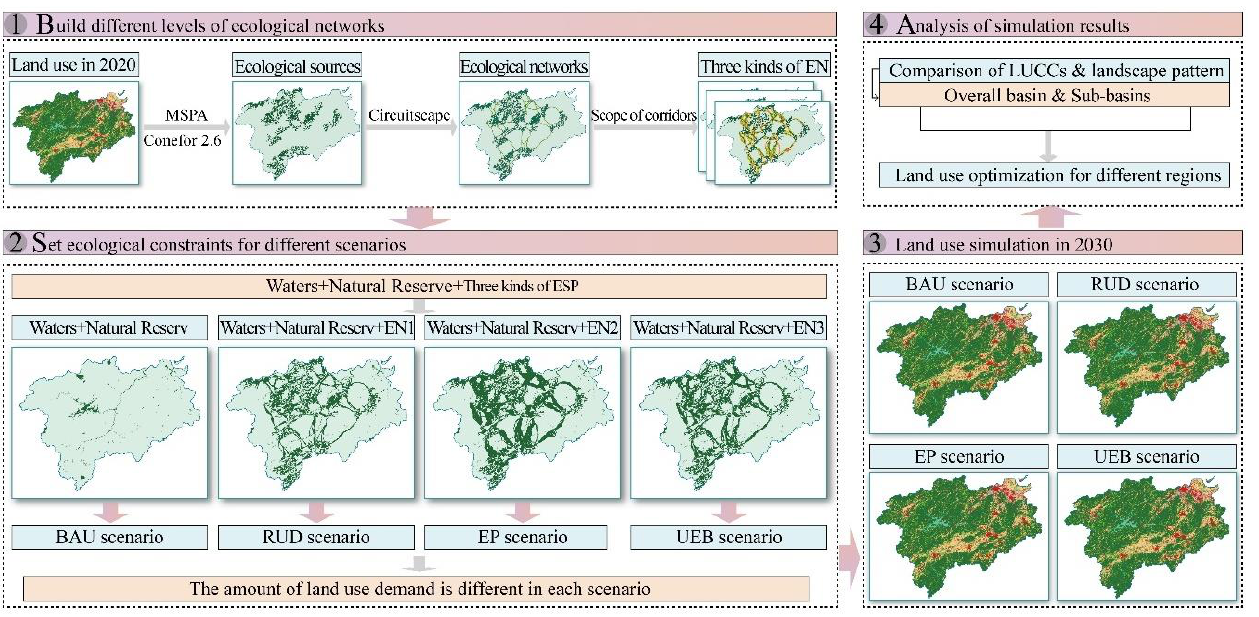
Figure 2. Framework of the EN-PLUS model.